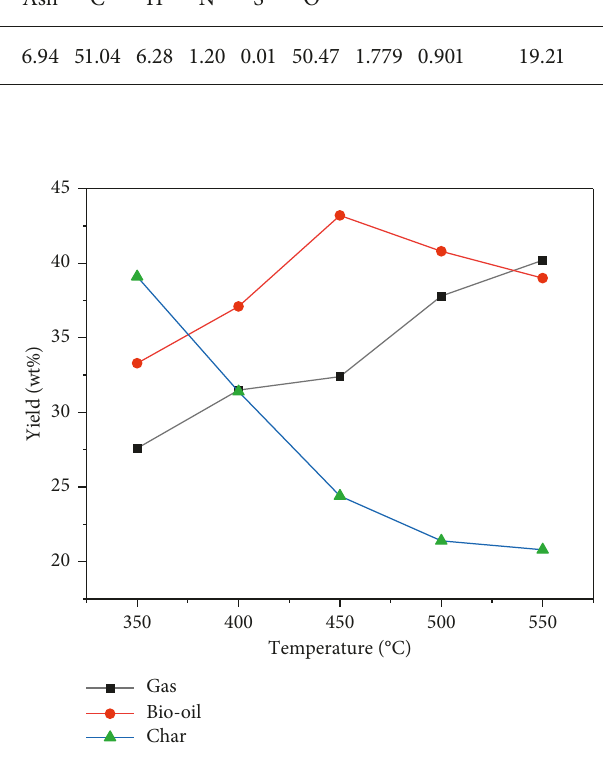
Figure 2: Effect of temperature on product